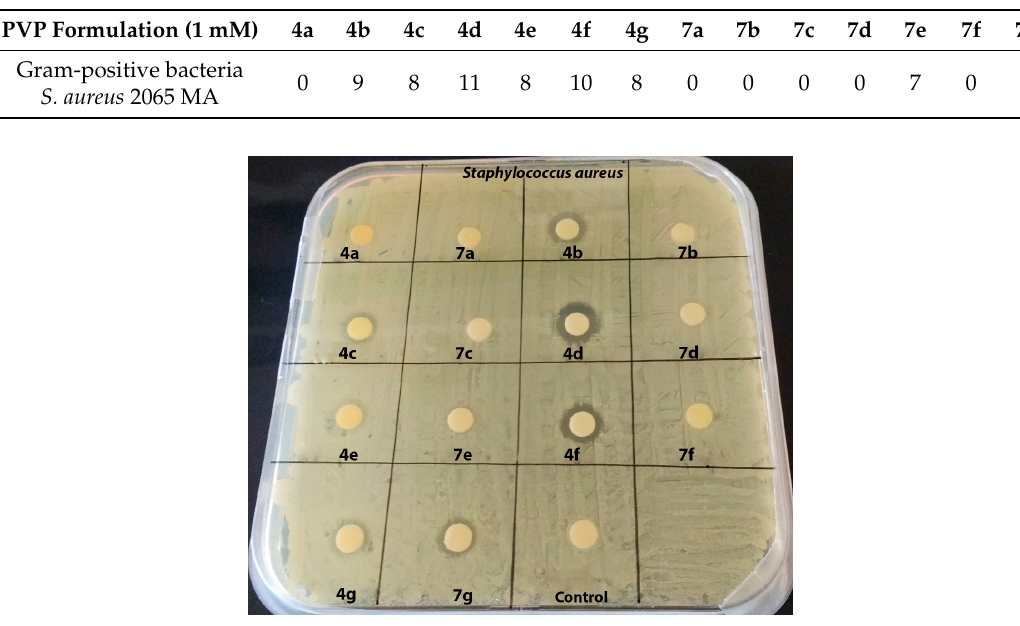
Figure 4. Picture of the plate containing Staphylococcus aureus plated on Mueller–Hinton agar and the discs immersed in the solutions of the formulations PVP-arylthio/cyclohexylthio-lapachones 4a – g and PVP-sulfonyl-lapachones 7a – g at concentrations of 1 mM (concentration of each lapachone derivative) after incubation overnight at 37 °C.